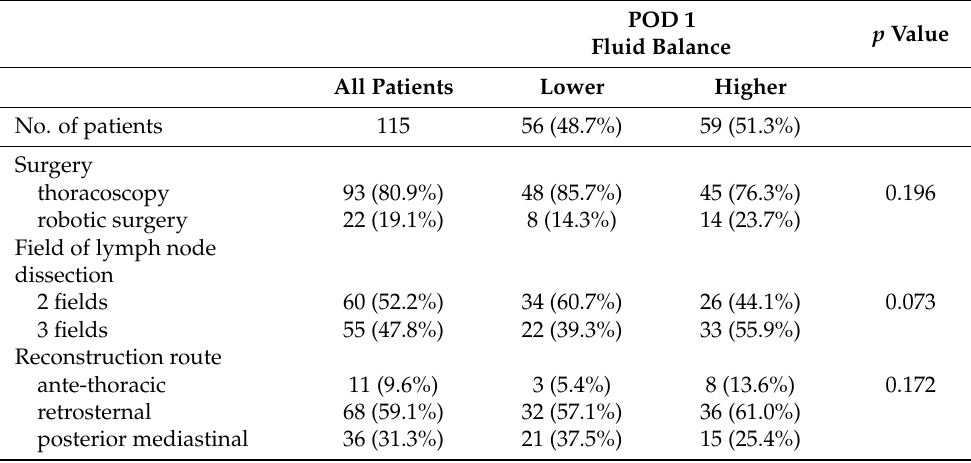
Table 3. Surgical factor and POD 1 fluid